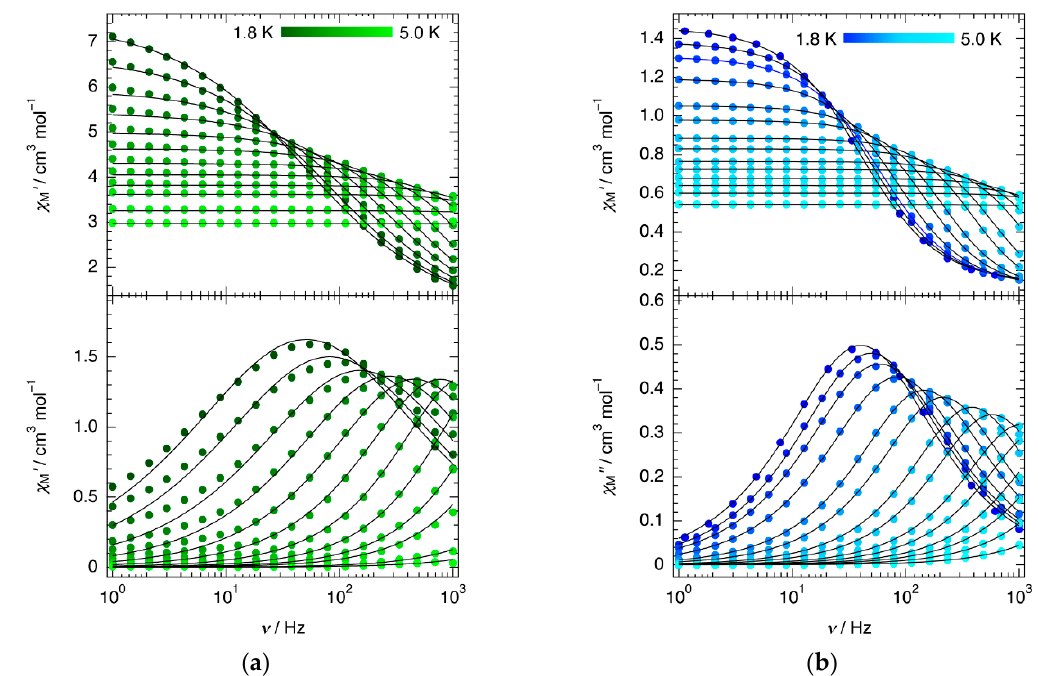
Figure 4. Frequency dependence of the molar in-phase (top) and out-of-phase (bottom) susceptibility for ( a ) 4 and ( b ) 5 over the frequency 1–1000 Hz and the temperature range 1.8–5.0 K in a 2.5 Oe ac field under an applied dc field of 0.1 T. The solid black lines represent fits to the experimental data using the generalized Debye model with the α parameter in the ranges of 0.08–0.42 for 4 and of 0.02–0.18 for 5 .